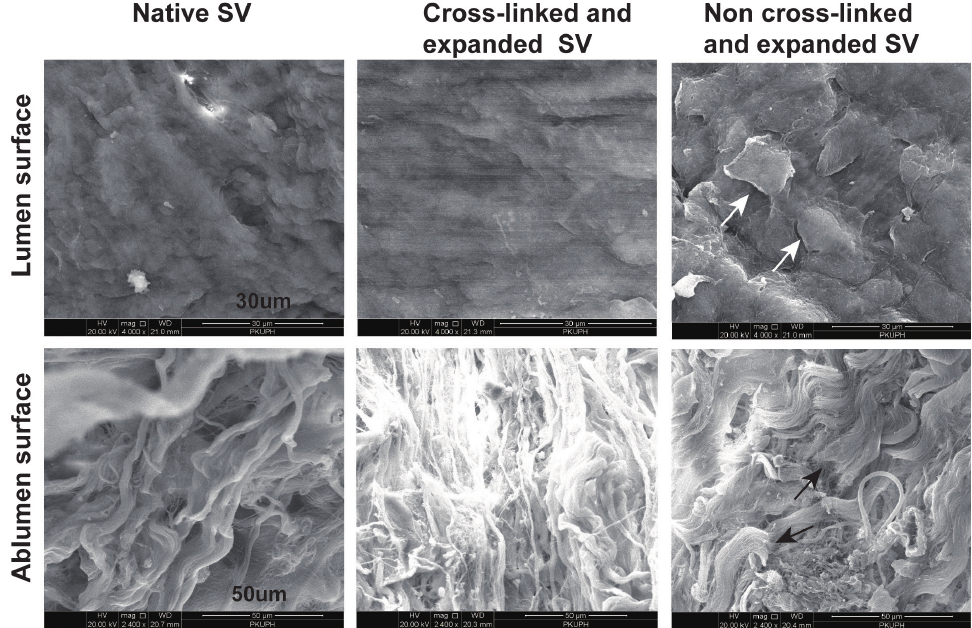
Fig. 3 - Scanning electron microscopy of human saphenous vein (SV). The ultrastructure of luminal and abluminal surfaces was observed in SVs with different processing (luminal surface magnification, ×4000; abluminal surface magnification, ×2400). The white arrows show patches of endothelium containing denuded and curly cells. The black arrows show fibre fracture.